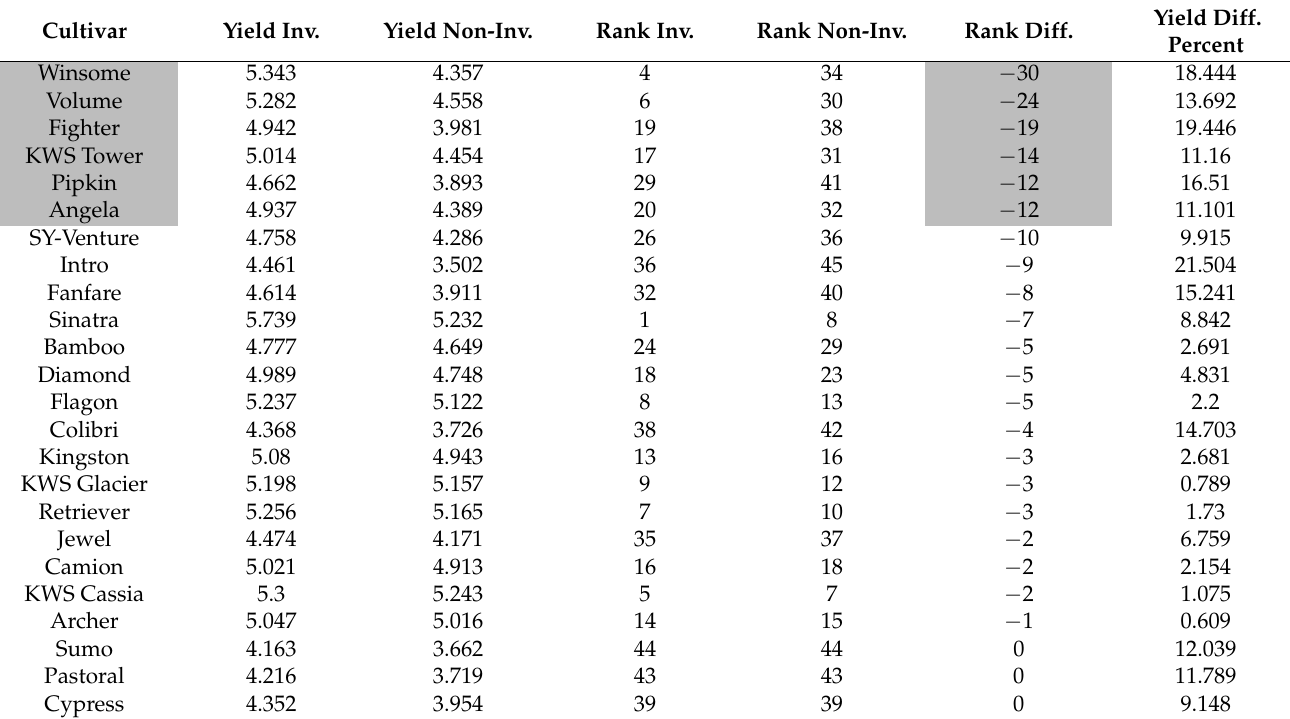
Table 10. Ranking of 45 winter barley cultivars grown in the 2011 trial by the difference between their inversion and non-inversion yield